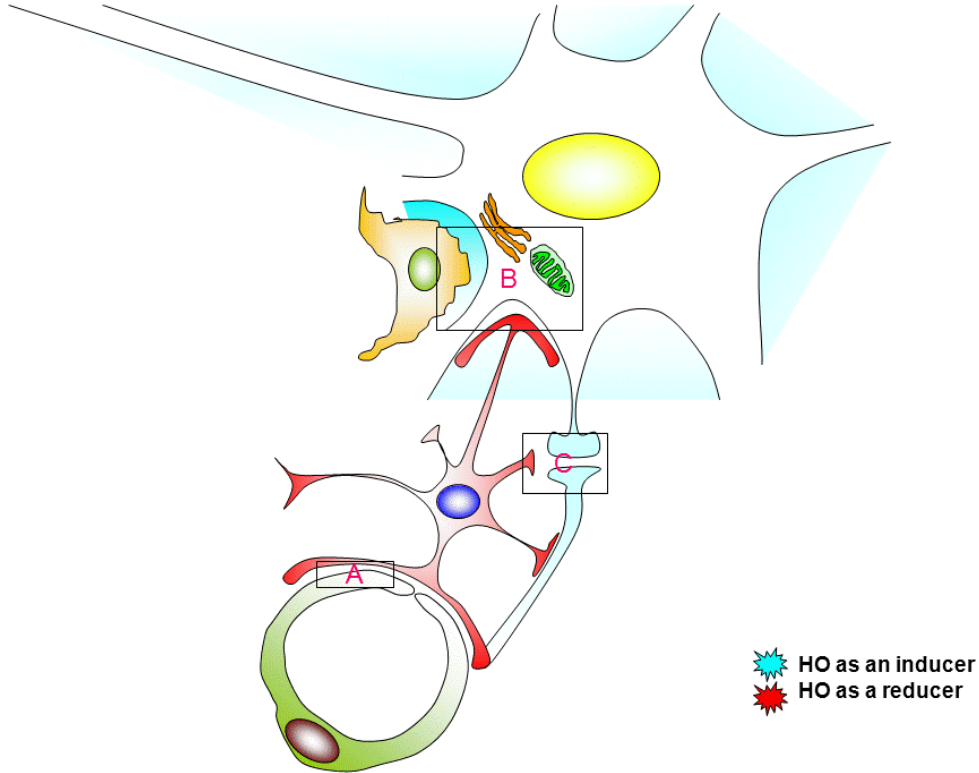
FIGURE 2. Extra- and intracellular signaling in postischemic brain injuries. See also Figs. 2- A1, 2-A2, 2-B, and